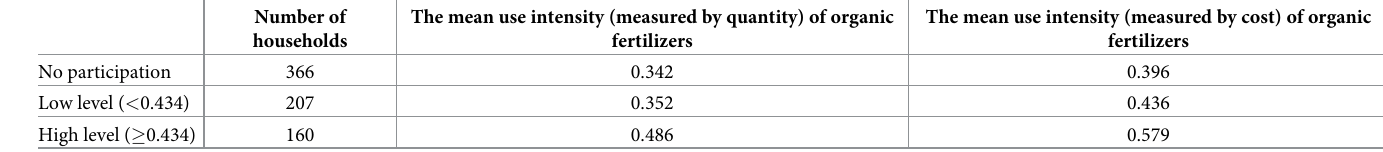
Table 2. Cross-statistical analysis of e-commerce participation and the use intensity of organic fertilizers. Number of